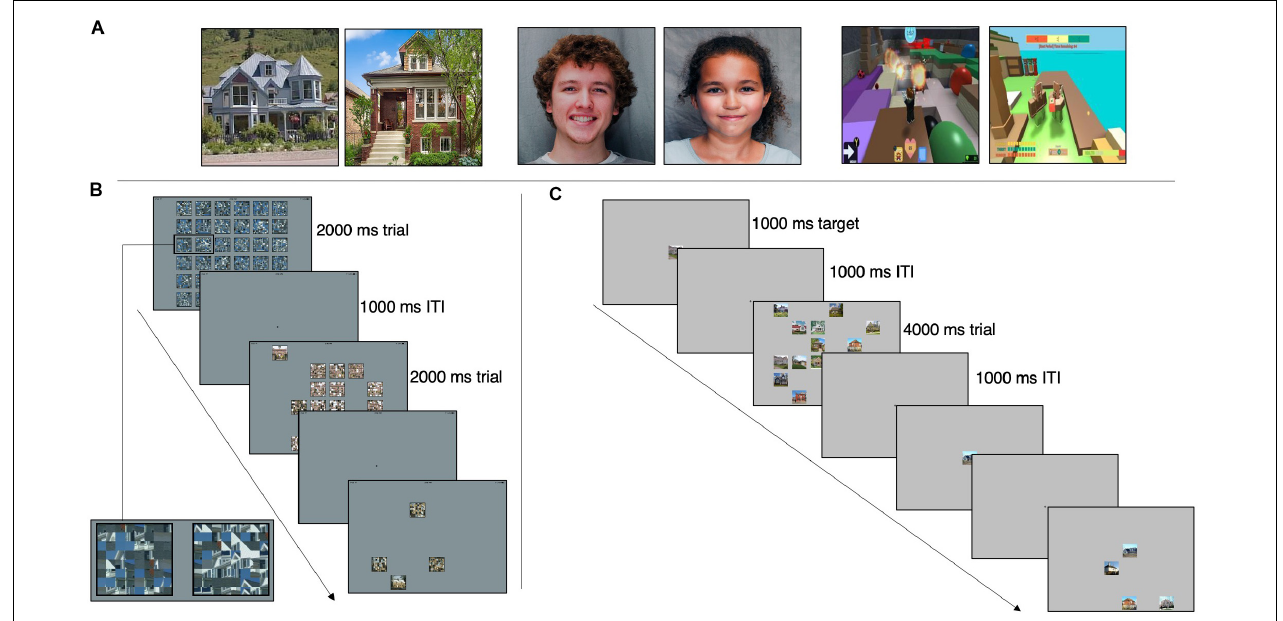
FIGURE 1 | (A) Example stimuli from the houses, faces, and interests categories (left to right). House stimuli are from Konkle et al. (2010) and face stimuli are from Meuwissen et al. (2017). (B) Category Search Task. Participants instructed to find the unscrambled image. Three example trials displayed. 36-image array presented for 2,000 ms with 35 scrambled images and one target, a 1,000-ms ITI, followed by a 16-image array and ITI, and lastly a four-image array. Box in first image of sequence is enlarged to show example of scrambled images. (C) Exemplar Search Task. Participants instructed to find the target image. Two example trials displayed. Target presented for 1,000 ms, a 1,000-ms ITI and a 16-image array with 15 distractors and the target image. A 1,000-ms ITI separates this trial from the next target presentation, which is part of a four-image array